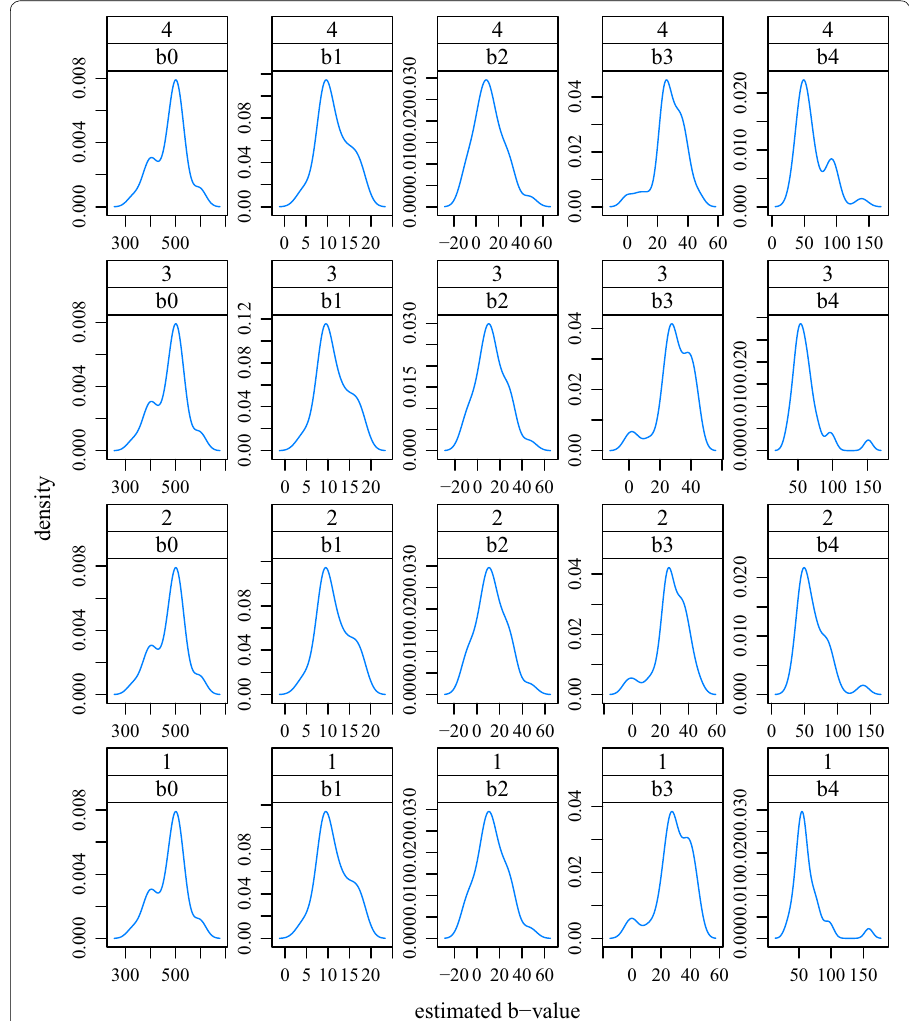
Fig. 1 Distribution of the fixed effects across countries given scaling model. 1 Scaling model 1—constant discrimination parameter across countries and items. 2 Scaling model 2—constant discrimination parameter across items but vary across countries. 3 Scaling model 3—discrimination parameter are constant across countries but vary over items. 4 Scaling model 4—discrimination parameter vary across countries and across items. b0 Intercept. b1 Individual effect of early literacy/numeracy tasks. b2 School effect of early literacy/ numeracy tasks. b3 Individual effect of home resource for learning index. b4 School effect of home